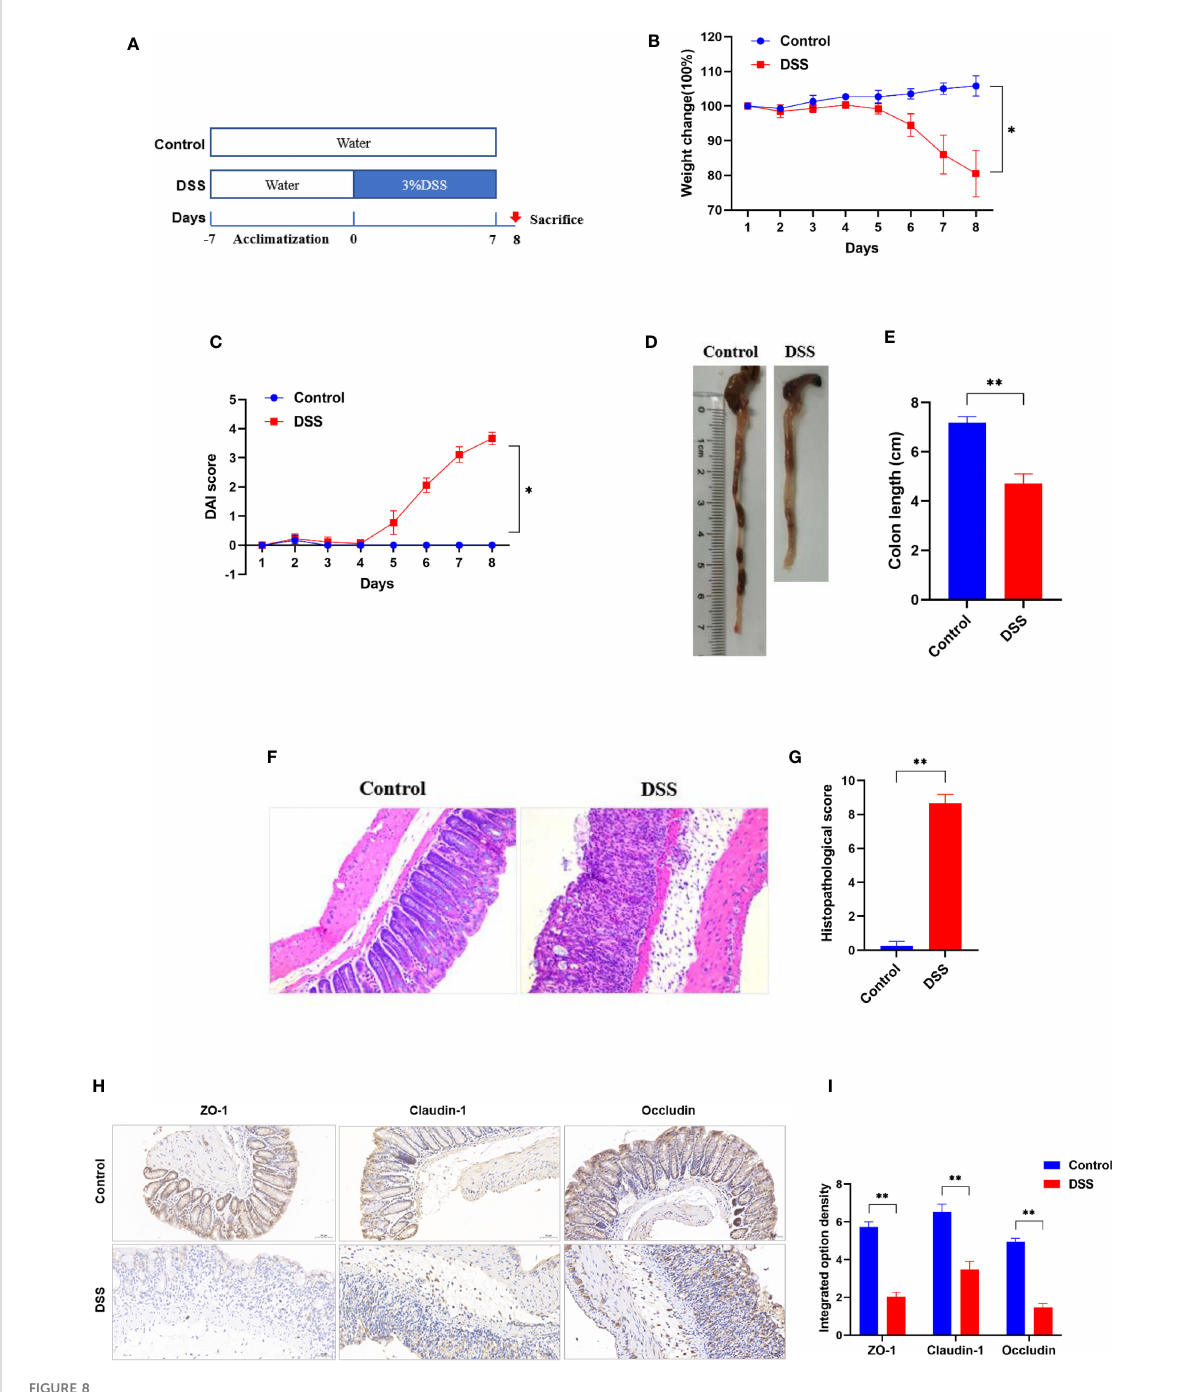
FIGURE 8 Successful establishment of DSS-induced colitis in vivo . (A) Schematic overview of DSS-induced colitis mice. (B) Daily changes in body weight and (C) DAI score in different groups (n = 6). (D) Representative colon pictures of mice from different groups and the comparison of colon length (n = 6). (E) Statistics of colon length. (F) Representative histopathological images of mice colon sections and histopathological scores (200× magni fi cation, n = 6). (G) The histopathological score. (H) Representative images of immunohistochemical staining of ZO-1, claudin-1, and occludin in colonic tissues (200× magni fi cation, n = 3). (I) The integrated option density was used in order to quantify ZO-1, claudin-1, and occludin proteins. *p < 0.05 compared to the control, **p < 0.005 compared to the